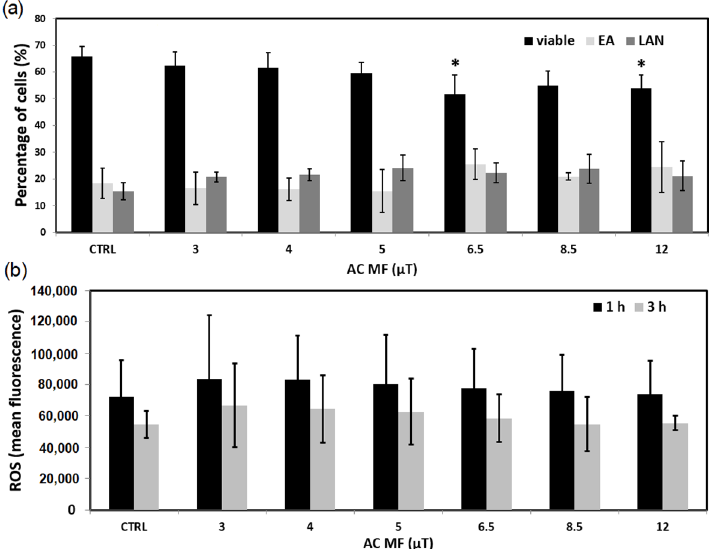
Figure 1. Exposure of UCBL to the 7.8tAM waveform during 72 h (N = 3). ( a ) Percentages of viable, early apoptotic (EA) and late apoptotic/necrotic (LAN) cells. ( b ) ROS production. All alternating current (AC) MF field values are peak values. * p < 0.05. Bars denote standard deviation (SD).